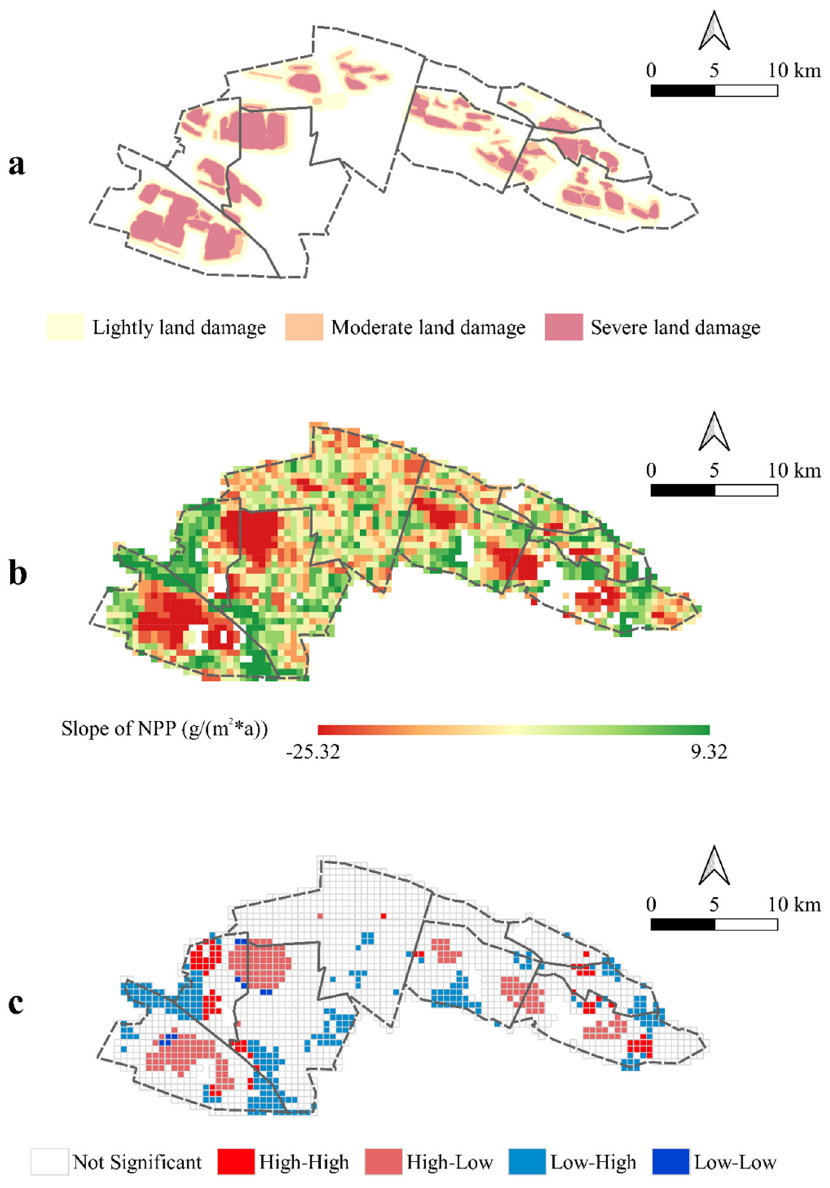
Figure 8. Influence range of coal mining and space analysis: ( a ) spatial distribution map of coal- mining subsidence damage; ( b ) trend map of NPP from 2001 to 2020; ( c ) LISA aggregation graph.